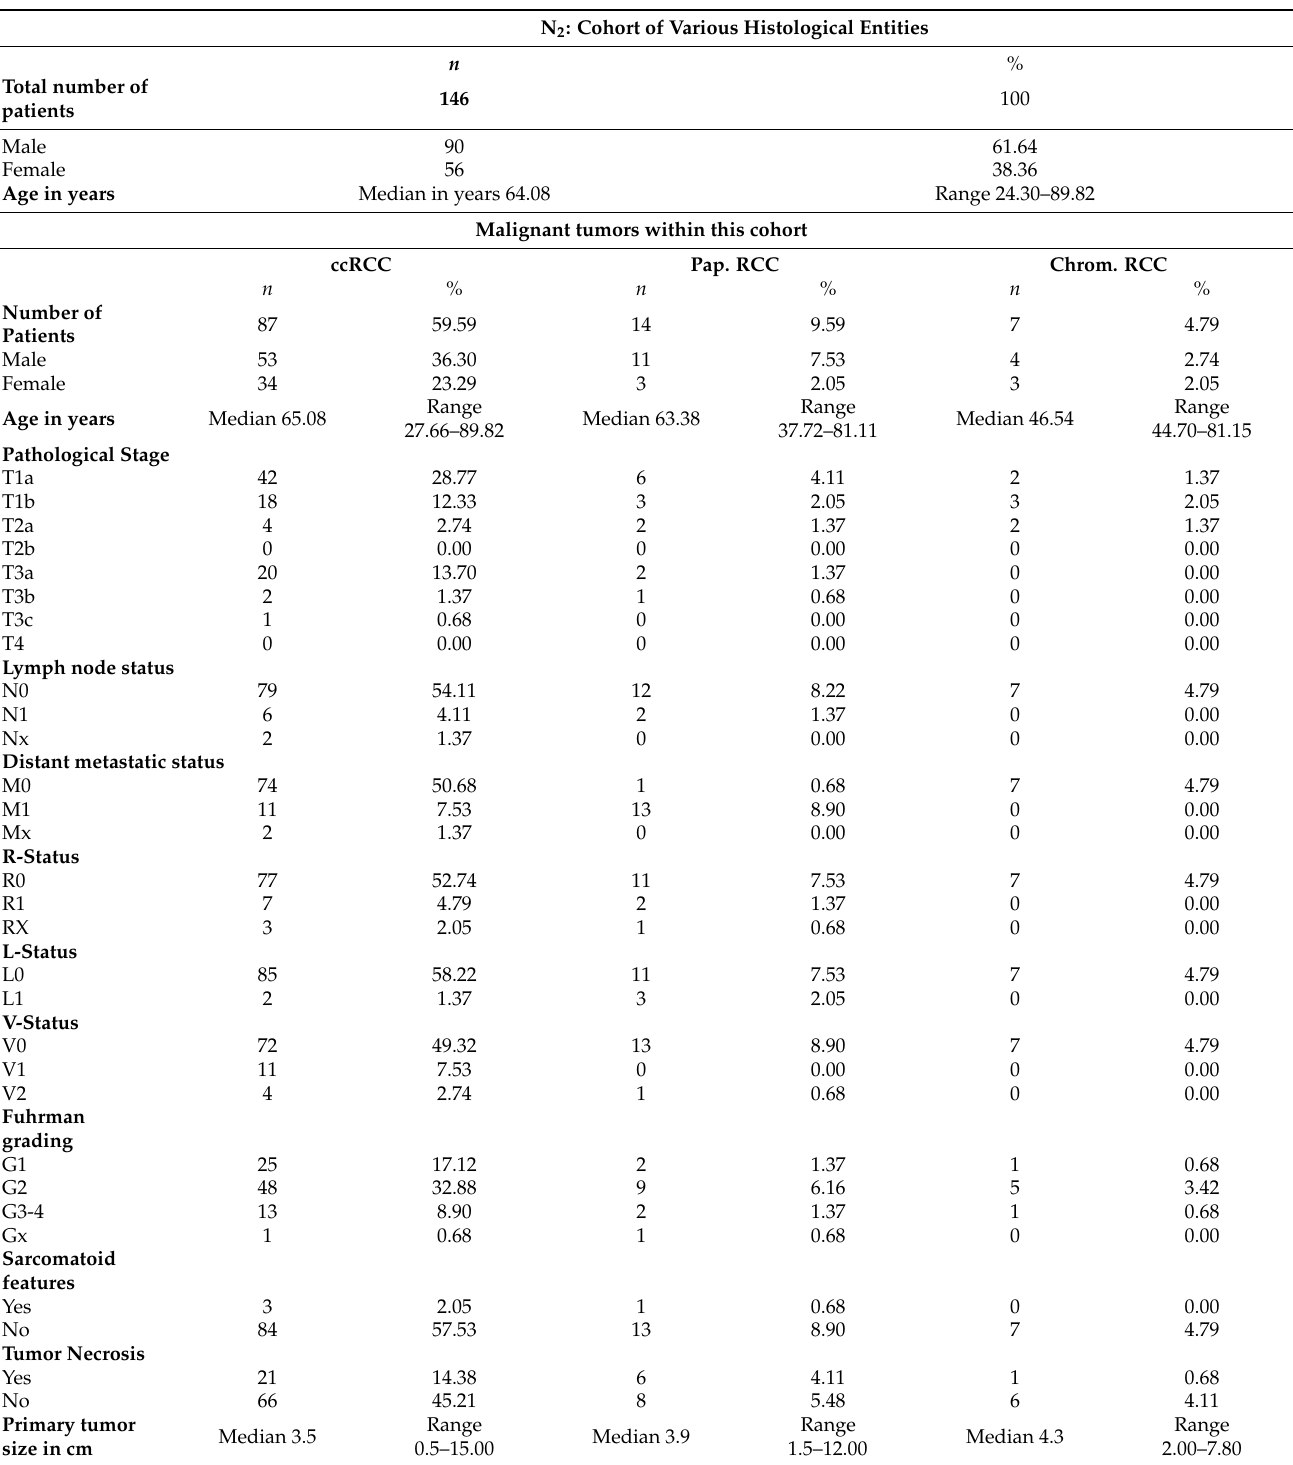
Table 2. Characteristics of patient cohort n 2 : cohort of various histological entities. N 2 : Cohort of Various Histological